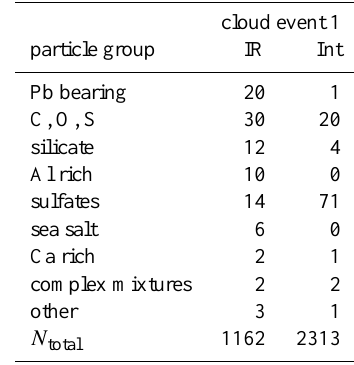
Table 4. Relative particle group number abundance [%] of the dif- ferent particle groups of ice residuals (IR) and interstitial (Int) sam- ples (0.1 ≤ d P ≤ 0 .